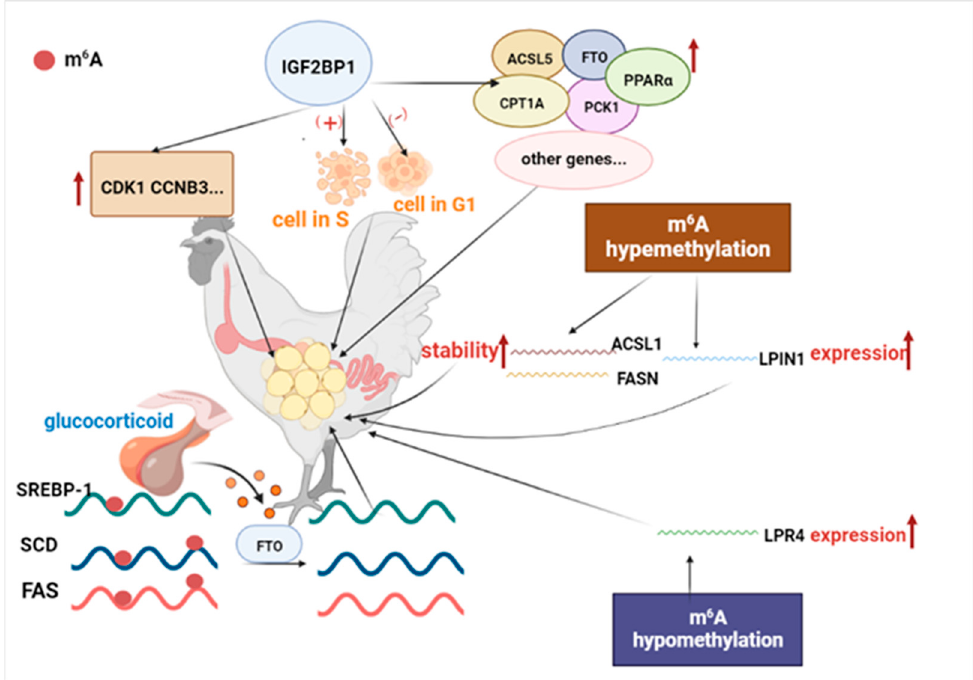
Figure 9. Regulation mechanism of poultry lipid metabolism by m 6 A. The figure shows the part of regulation of m 6 A on poultry lipid metabolism. regulation of m 6 A on poultry lipid